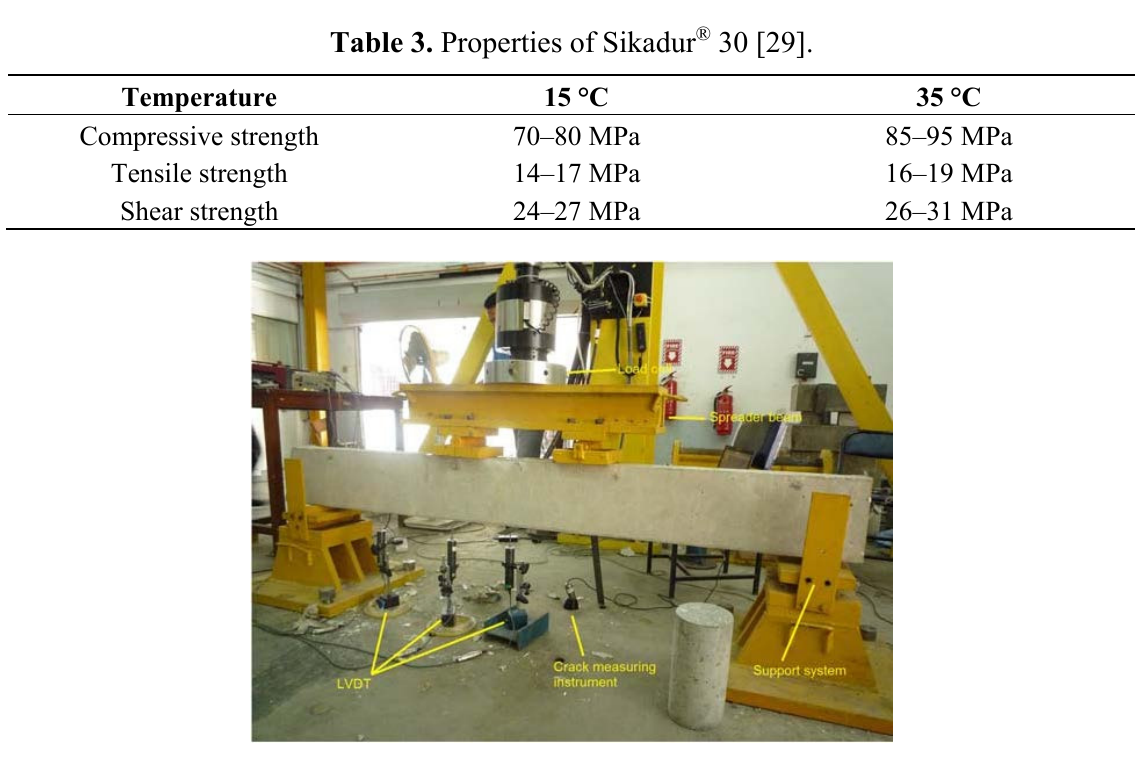
Figure 8. Experimental